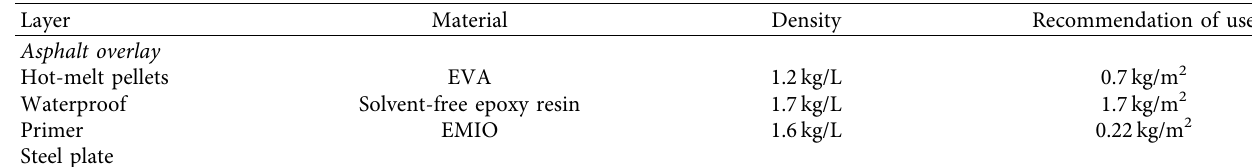
Figure 1: Composite bonding structure. (a) Structure model and (b) cross section. Table 1: Material properties of the composite bonding structure [24].